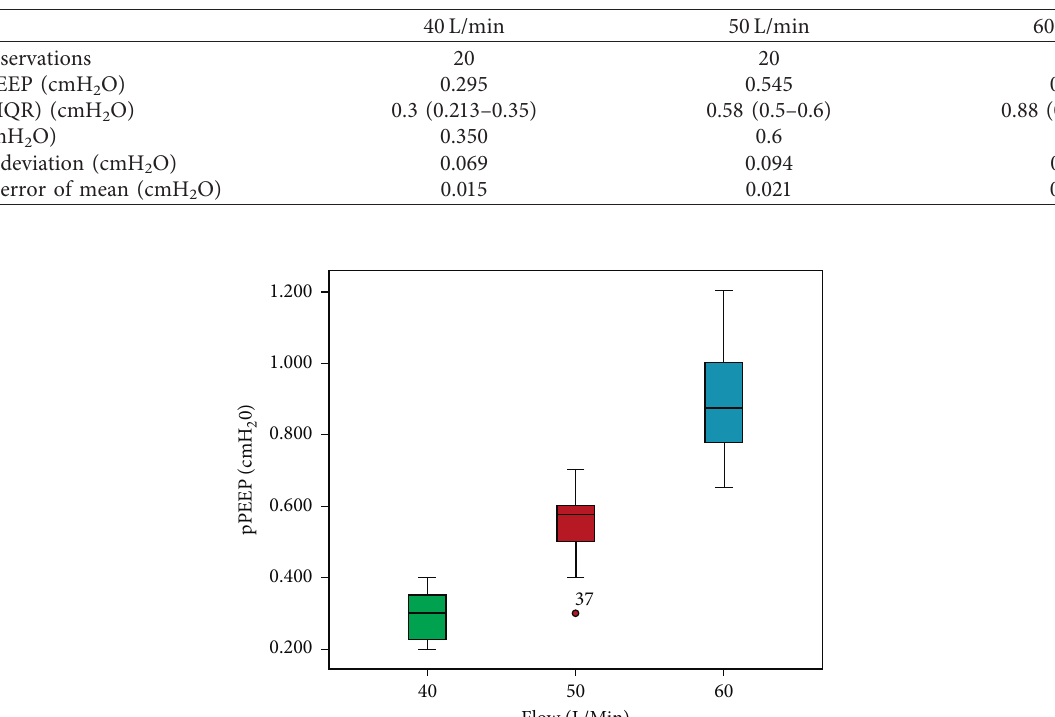
Table 3: Descriptive statistics comparing flows.